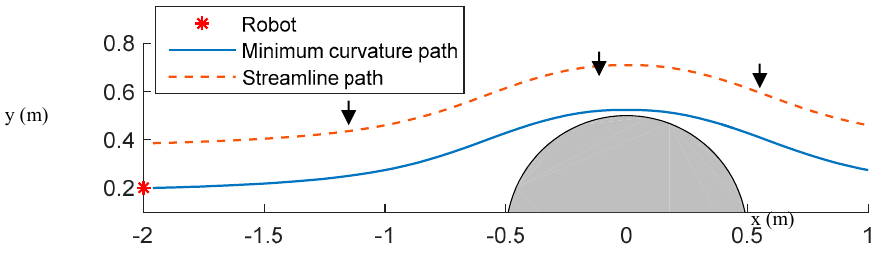
Figure 8. The concept of the low curvature path.